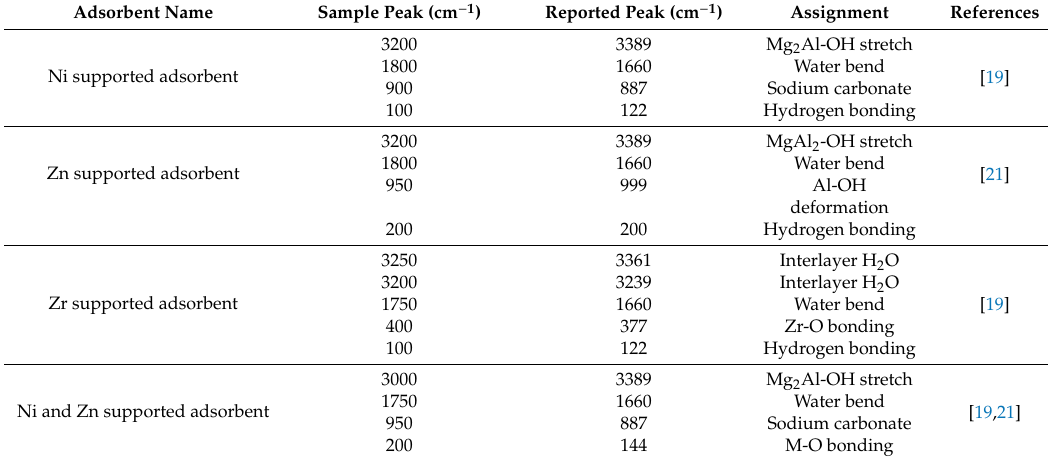
Table 2. Raman peak list of the five